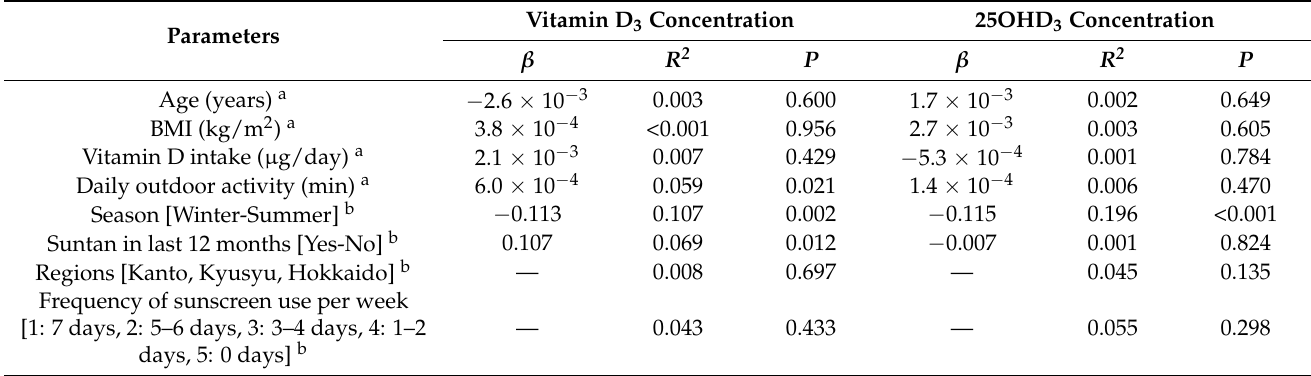
Table 4. Association between parameters and vitamin D 3 or 25OHD 3 concentration in breast milk.